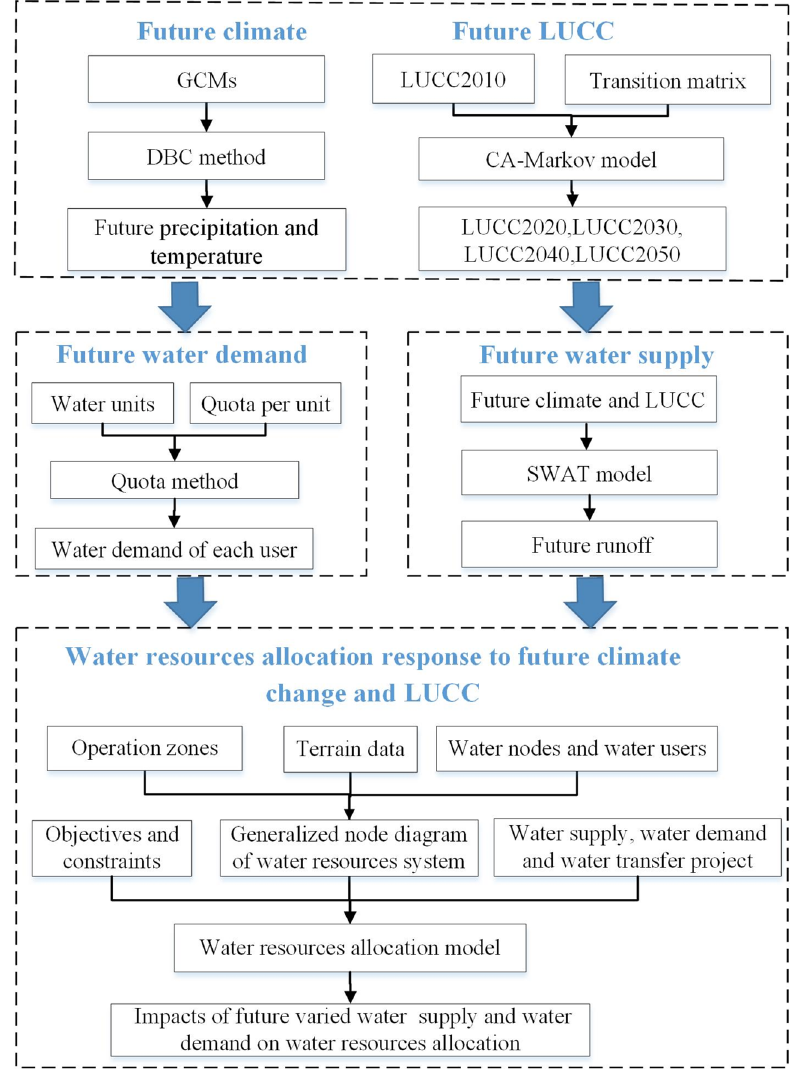
Figure 1. The framework of water resources allocation assessment under future climate change and LUCC. (This figure is generated by Visio2016 software. URL link: https:// www. micro soft. com/ zh- cn/ downl oad/ detai ls. aspx? id=